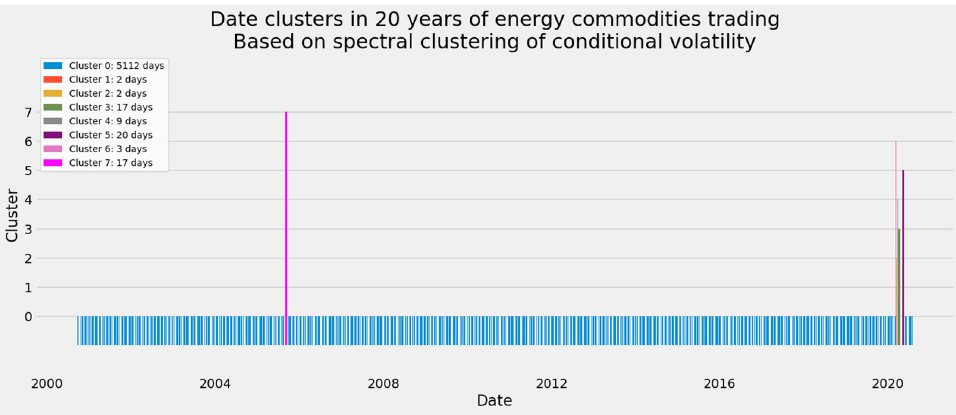
Figure 19. Spectral clustering of commodity markets—An ordered